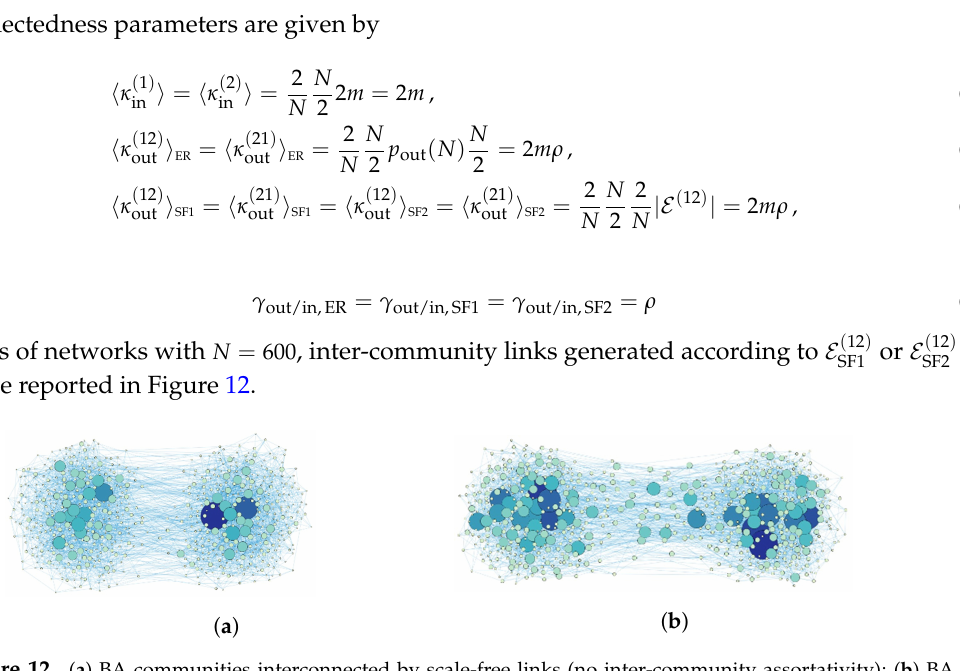
Figure 12. ( a ) BA communities interconnected by scale-free links (no inter-community assortativity); ( b ) BA communities interconnected by scale-free links (with inter-community assortativity). In both cases, N = 600, ρ = 0.1, the size of each node is proportional to its overall degree and the spatial position of nodes represents the equilibrium configuration of the Force Atlas visualization algorithm